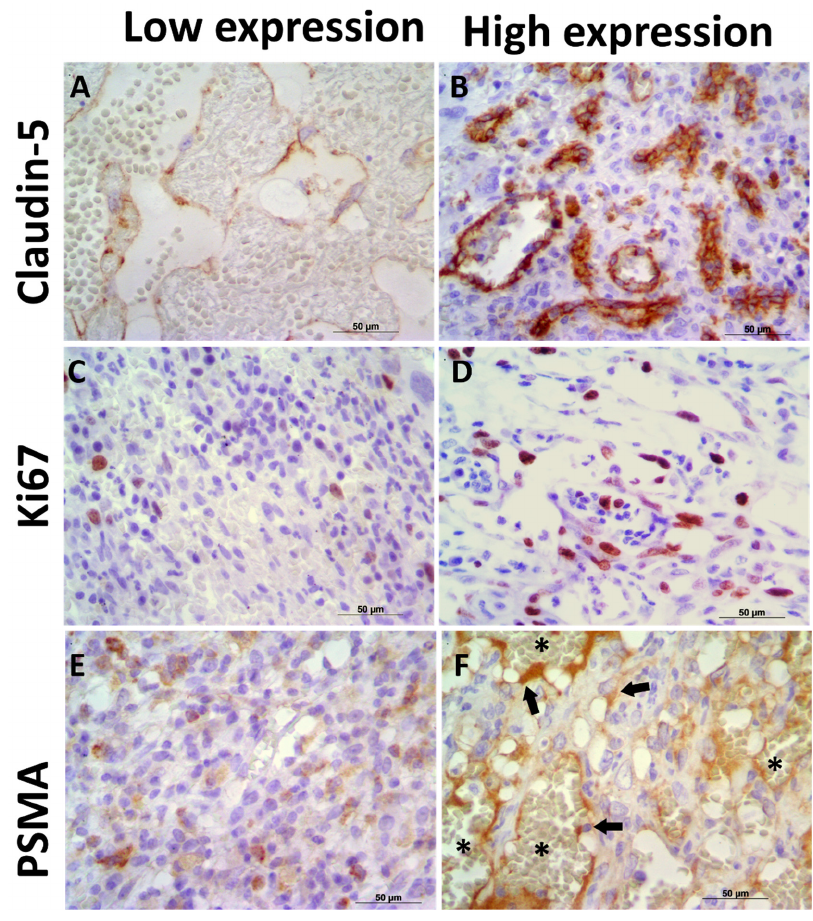
Figure 2. Immunoexpression of Claudin-5, PSMA, and Ki67 in canine hemangiosarcoma (HSA) samples. ( A ) Low Claudin- 5 immunoexpression in a capillary HSA sample. ( B ) Canine HSA showing high Claudin-5 expression in neoplastic endo- thelial cells. ( C ) Low Ki67 expression in a solid HSA sample. ( D ) High Ki67 expression in a canine HSA sample. ( E ) Low PSMA expression in a solid HSA sample. ( F ) High PSMA expression in neoplastic endothelial cells (arrows) in a capillary